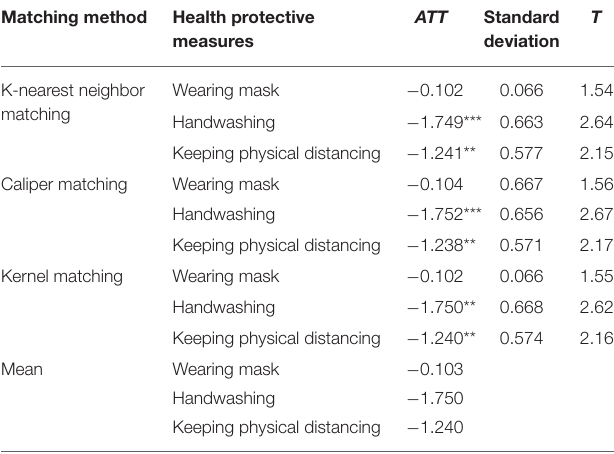
TABLE 5 | The effect of the COVID-19 vaccination on participants’ health-protective measures. Matching